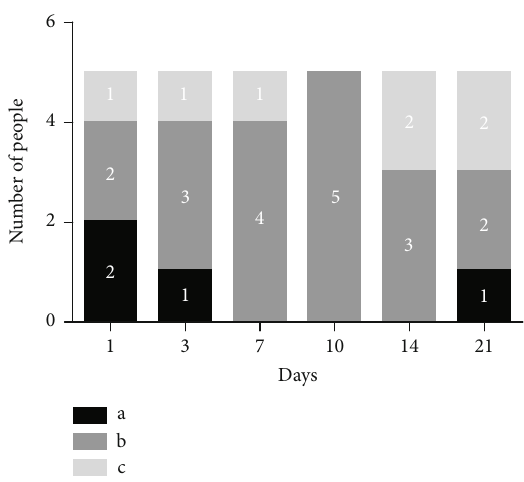
Figure 4: Comparison of pain experiences between bilateral surgeries. The days represent the various groups in accordance with the interval between bilateral surgeries. a: “ I had more pain during the fi rst surgery ” ; b: “ I had more pain during the second surgery ” ; c: “ I experienced the same pain during both surgeries ” . The bar graph shows the number of people who chose the